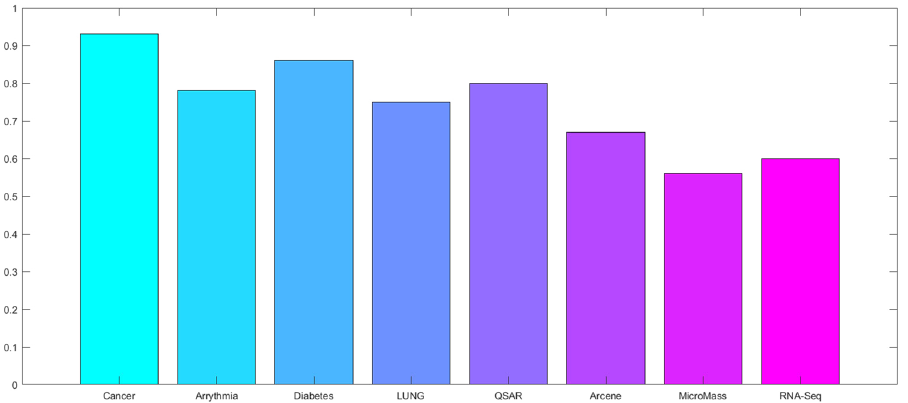
Figure 9. The performance of the SVM without applying FS algorithms on the datasets.